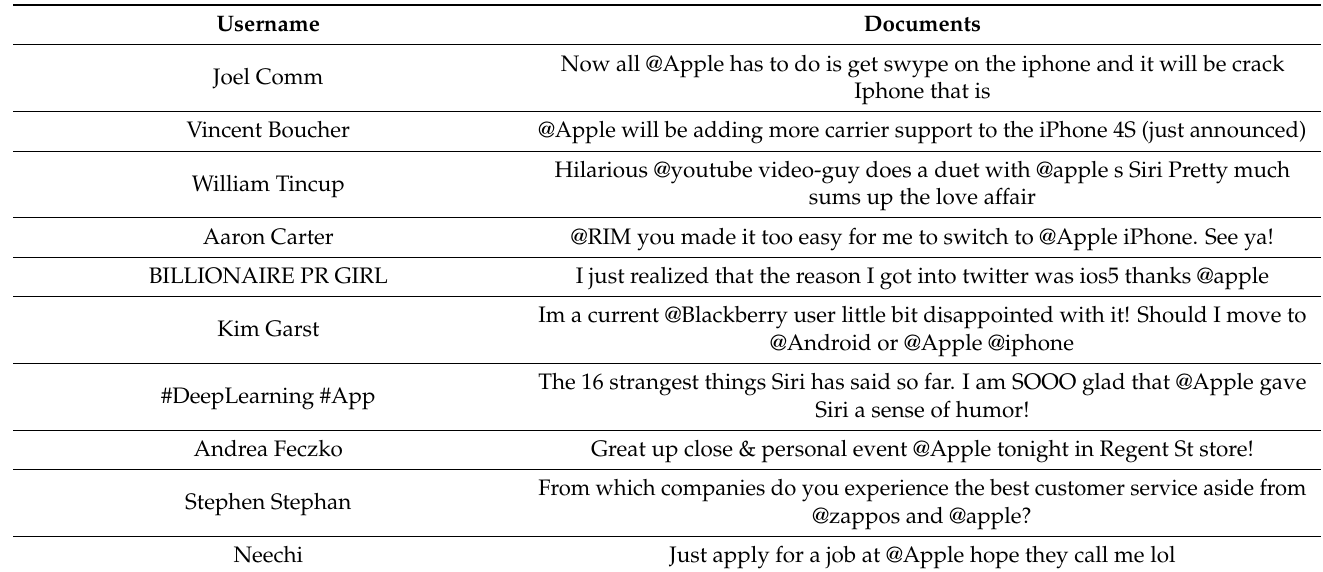
Table 3. Apple Event, Twitter Comment Data Set